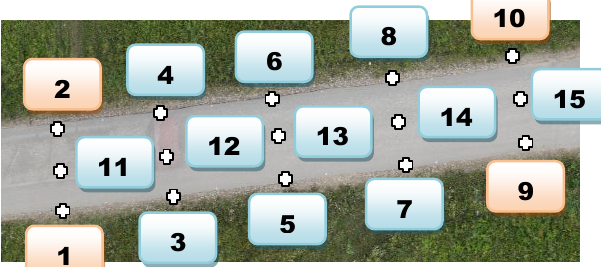
Figure 11. Scheme of reference and control points